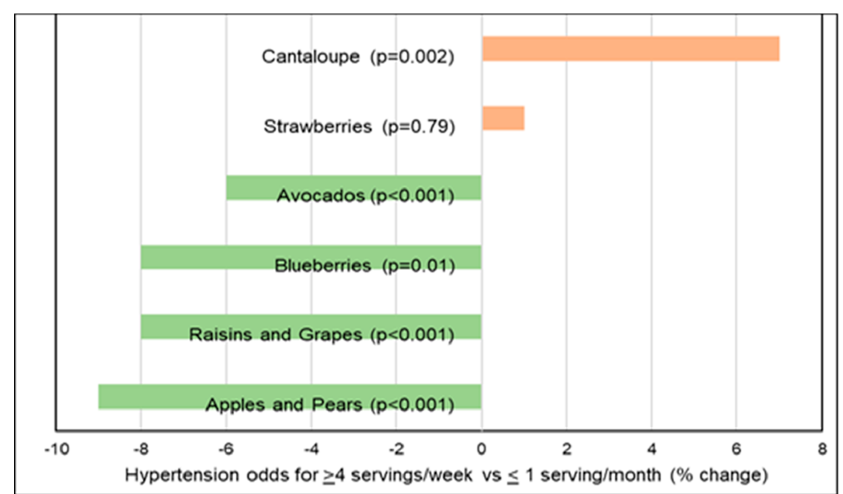
Figure 11. Change in the risk of hypertension associated with fruit consumption from pooled Nurses’